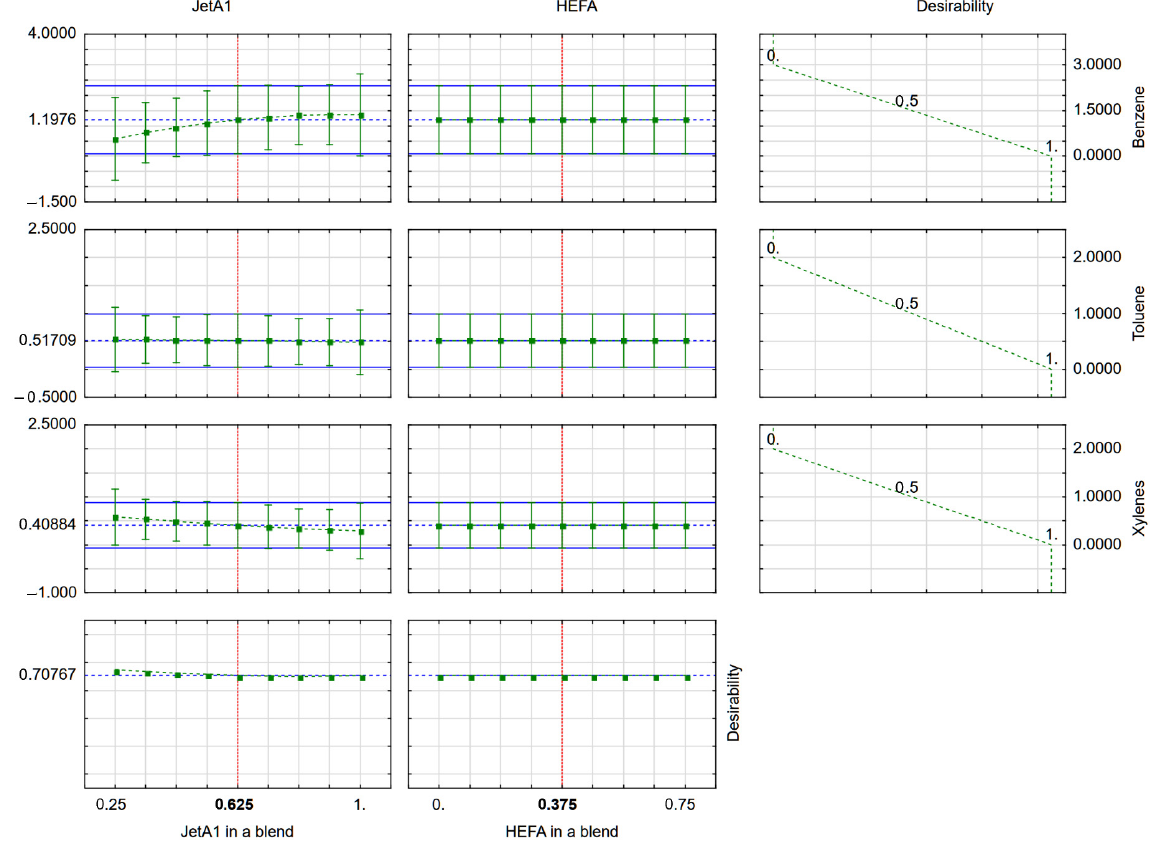
Figure 5. Desirability function determining the effect of BTX compounds on the fuel blend contents.